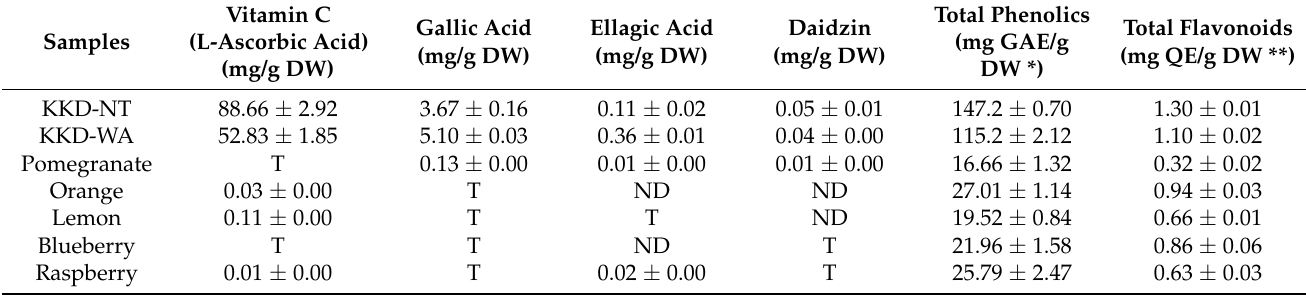
Table 2. Total amount of vitamin C, phenolics, total flavonoids of KKD-NT and KKD-WA and other fruits.